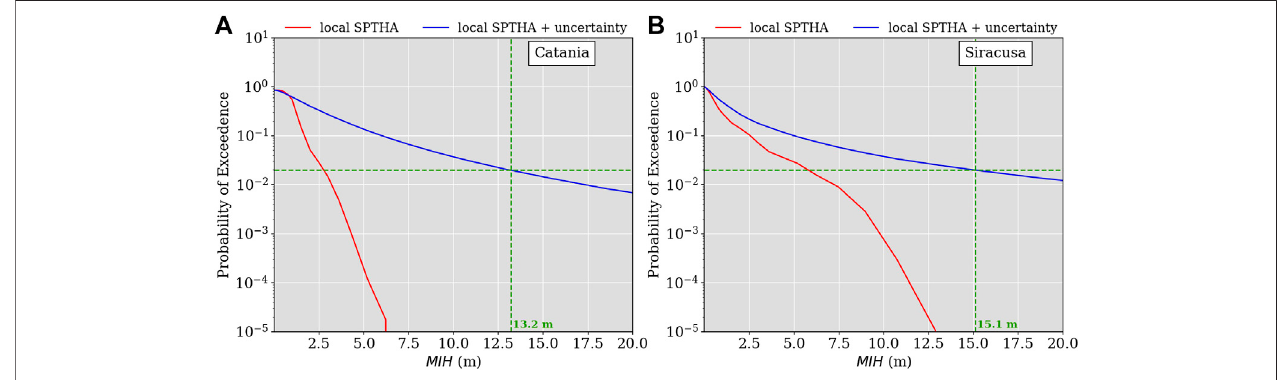
FIGURE12| ExampleofhazardcurvescalculatedonlandthroughthelocalSPTHAwithout(redlines)andwith(bluelines)theepistemicuncertainty.Theselectedcurvesare the ones corresponding to the maximum intensity in Catania (panel A , 13.2 m) and Siracusa (panel B , 15.1 m) at the ARP equal to 2,500 years (green dashed lines).